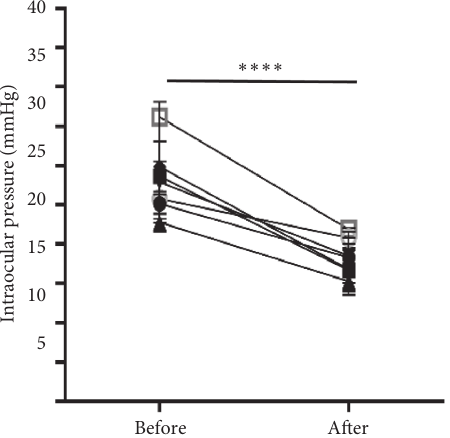
Figure 2: The mean preoperative and postoperative IOP in horizontal vision are 27.4 ± 4.6mmHg and 18.0 ± 2.7mm